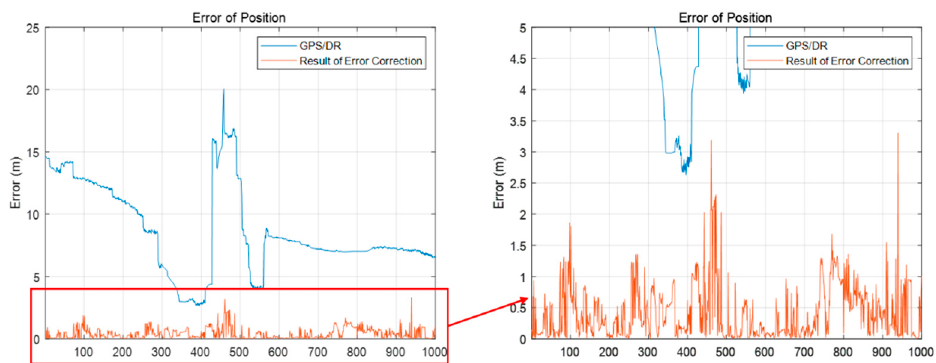
Figure 28. Flowchart of error correction of initial vehicle position.